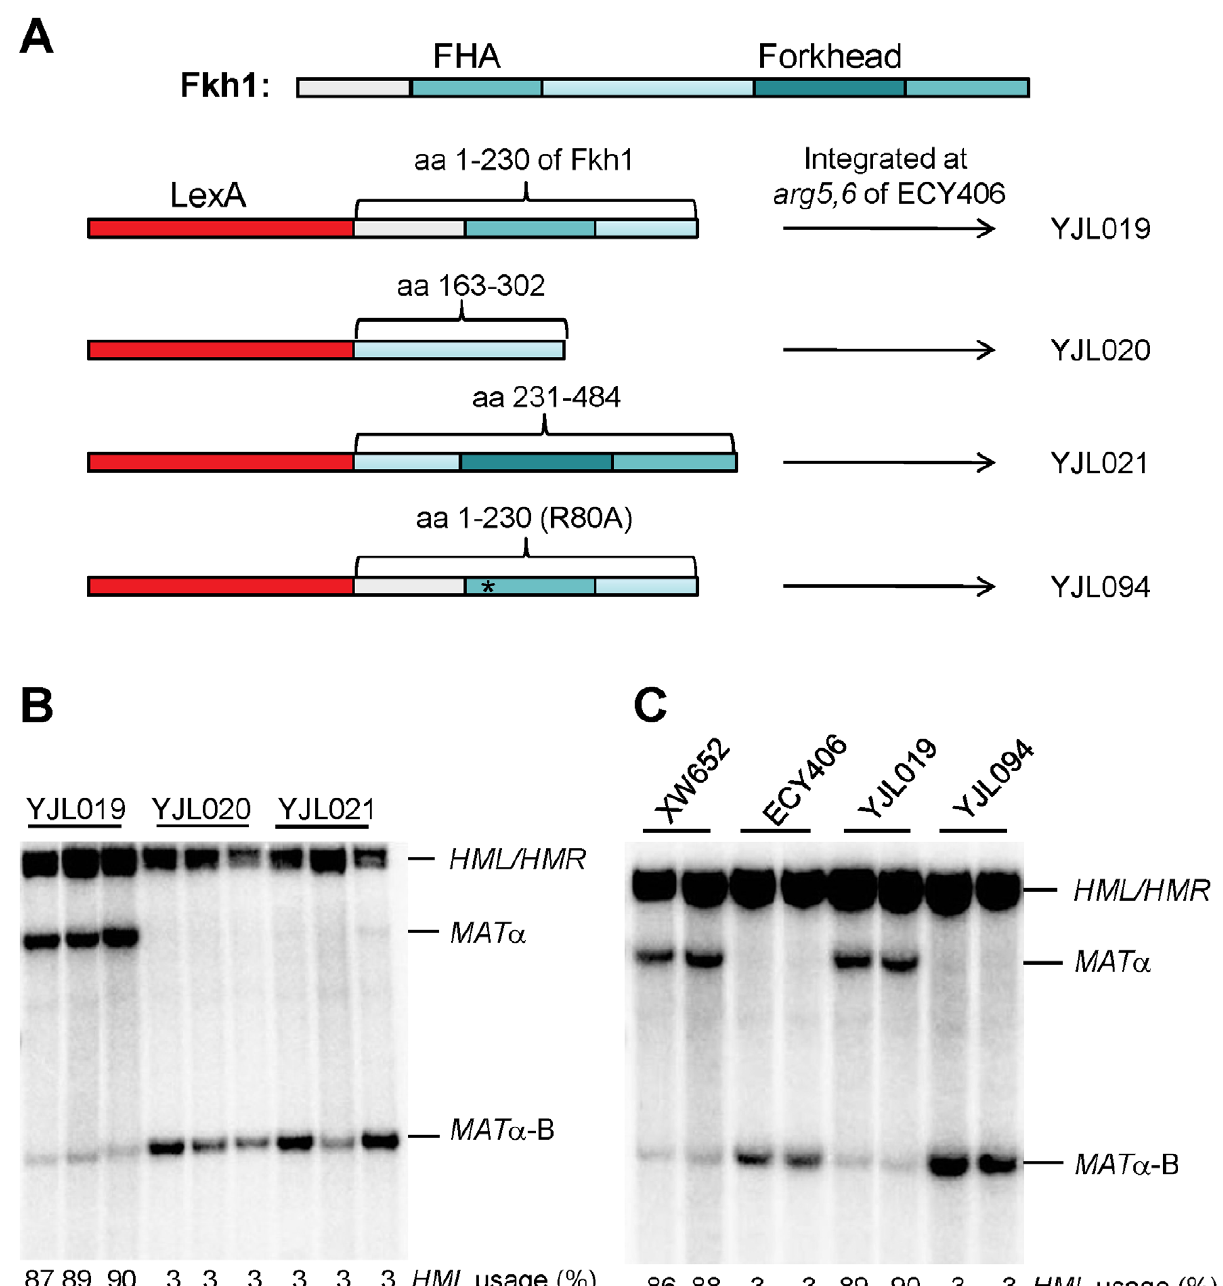
Figure 3. The FHA Domain of Fkh1 Is Responsible for Donor Preference Regulation. (A) The strain construction strategy for YJL019, YJL020, YJL021 and YJL094. Fkh1 has two conserved domains: FHA and a forkhead DNA binding domain. We prepared three plasmid constructs by fusing LexA of pAT4 with different regions of Fkh1: pJL4 for LexA-FHA (aa 1–230 of Fkh1), pJL5 for LexA-interdomain (aa 163–302), and pJL6 for LexA- forkhead (aa 231–484), respectively. LexA-fused sequences from these plasmids were integrated to the arg5,6 locus of ECY406 (Figure 2A) to generate yeast strains YJL019, YJL020 and YJL021, respectively. For YJL094, LexA-fused sequences (LexA-FHA-R80A) from pJL8 were integrated. (B) FHA domain of Fkh1 is responsible for the regulation of donor preference. Donor preference was measured by Southern blot in panels B and C. (C) The phosphothreonine binding motif of FHA domain plays a critical role in the regulation of donor preference. XW652 and ECY406 serve as positive and negative controls, respectively. HMR (Figure 4A), so that DSBs could not be repaired by using primer pairs that amplify regions further away from the HO homologous recombination. We observed a . 10-fold increase in site (Figure 4B). Therefore, the LexA-FHA Fkh1 fusion protein ChIP signals within about 5 kb on either side of the HO cleavage physically interacted with the DSB-cut MAT through a repair- site at the MAT , whereas no significant signal could be detected independent mechanism, which suggests that LexA-FHA Fkh1 or